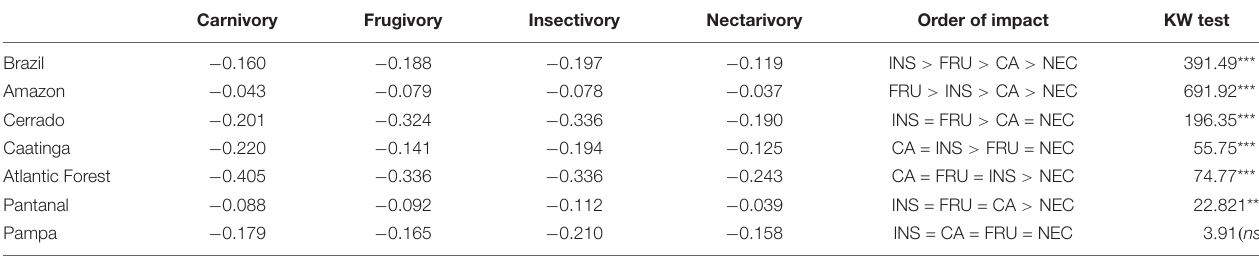
TABLE 4 | Magnitude of ecosystem services in Brazil and its biomes per feeding guilds.